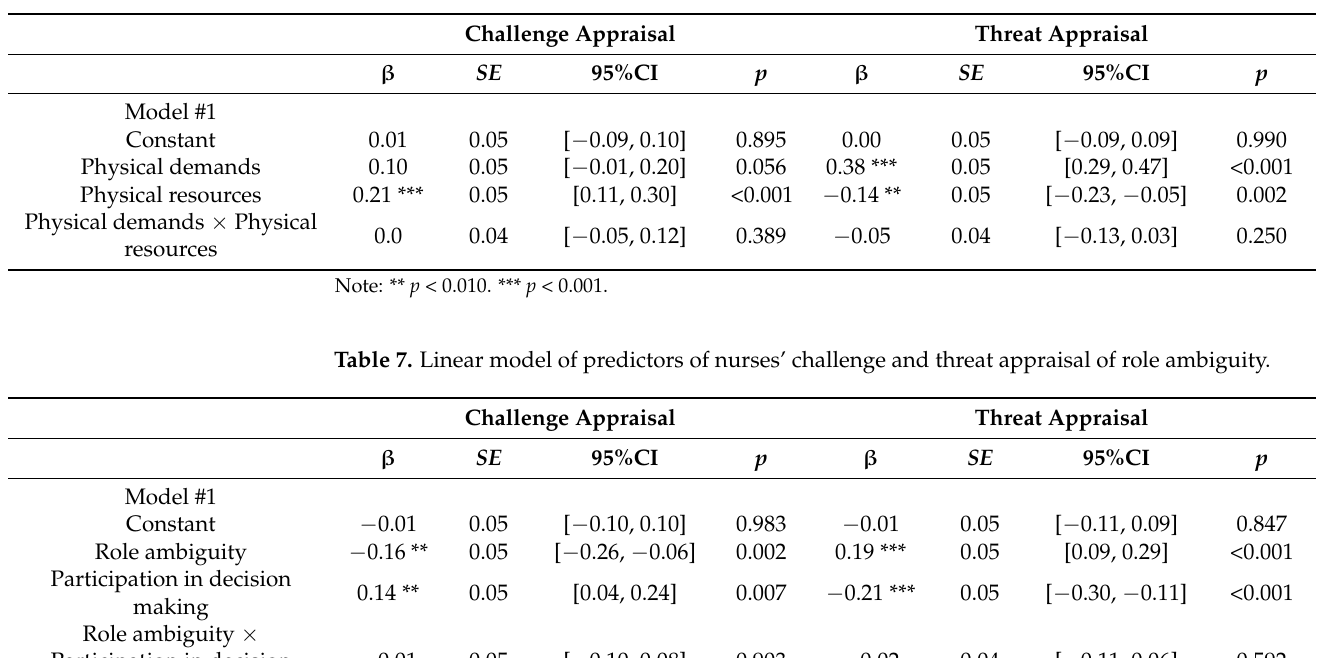
Table 6. Linear model of predictors of nurses’ challenge and threat appraisal of physical demands.